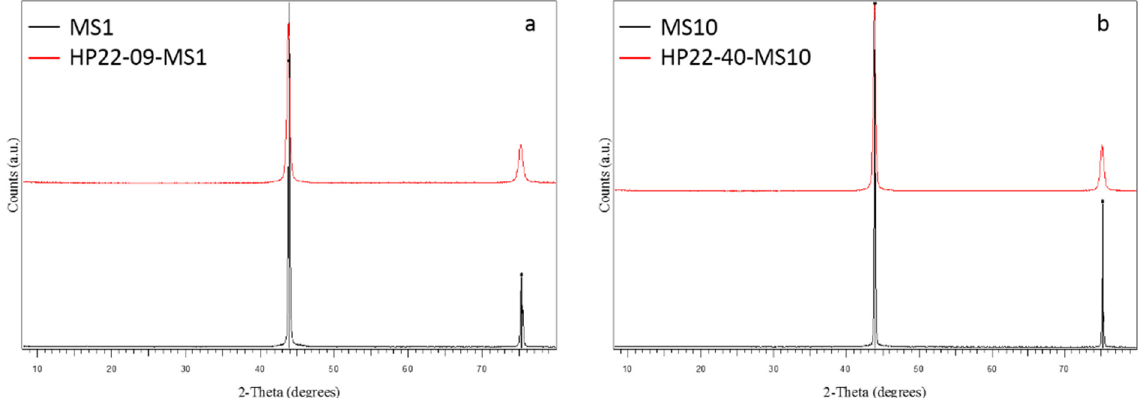
Figure 4. XRD patterns of starting materials (black) and run products after experiments (red): ( a ) For the experiments conducted with 0.75–1.25 μ m grain size powder and ( b ) with 8–12 μ m grain size powder. The starting powders are very pure, and grains are well crystalized (sharp peaks). After experiment, diamond is fully conserved with no evidence of graphite back transformation. It is of note that diffraction peaks in experimental products are wider than in the starting powder.